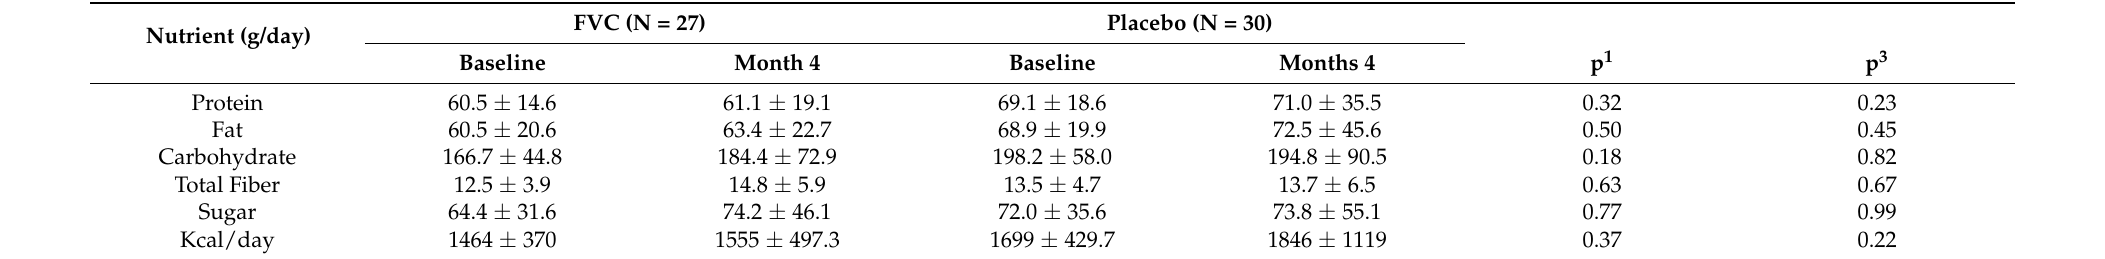
Table A1. Nutrient analysis for FVC vs. Placebo at baseline and at month 4.